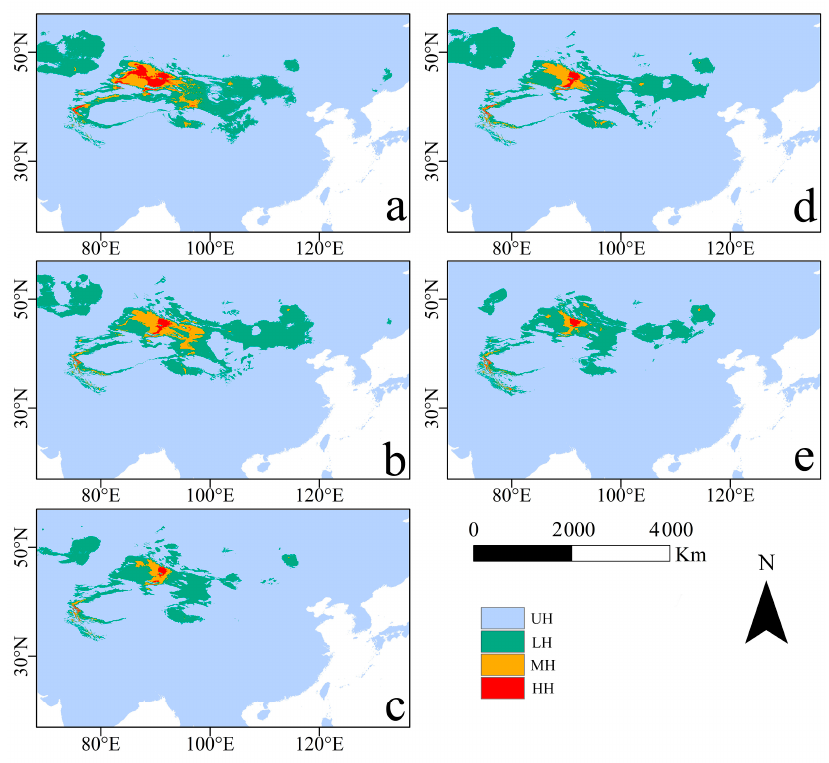
Figure 2. Potential suitable habitat maps of the current period, 2050s, and 2070s: ( a ) current; ( b ) 2050RCP2.6; ( c ) 2050RCP6.0; ( d ) 2070RCP2.6; ( e ) 2070RCP6.0. UH, LH, MH, and HH represent unsuitable habitat, low suitable habitat, middle suitable habitat, and high suitable habitat, respectively.